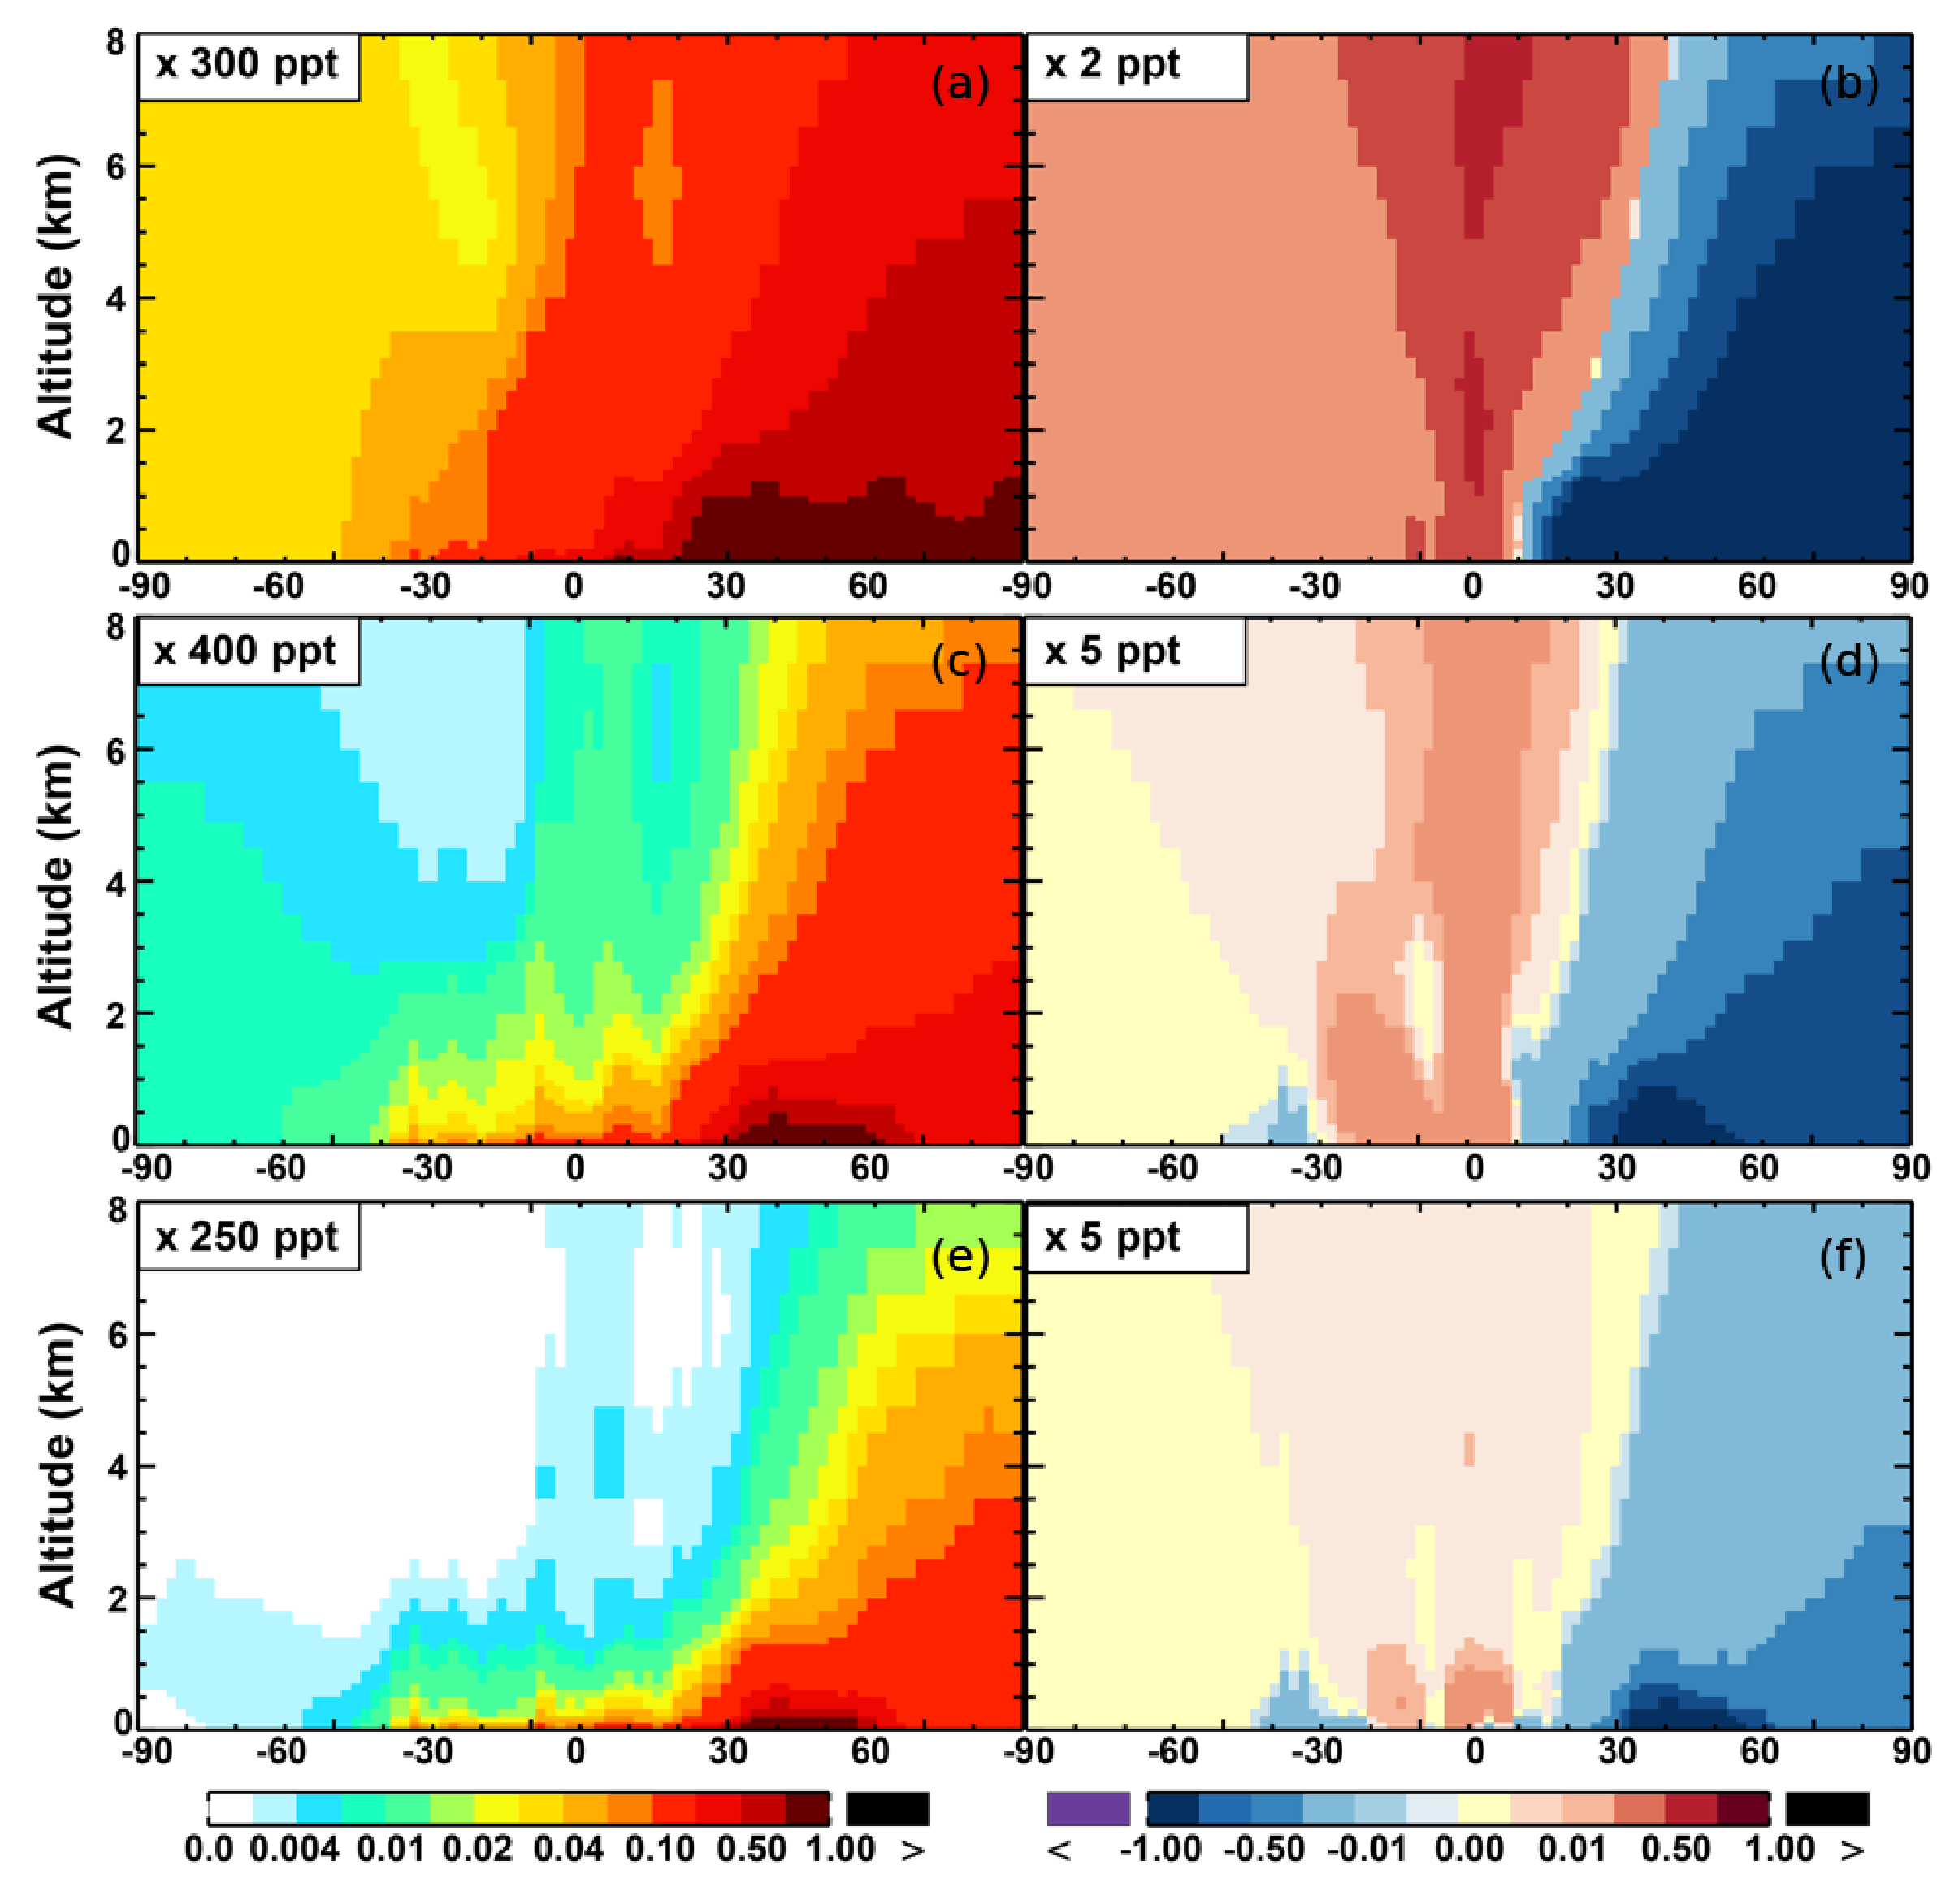
Same as Fig. 7 but for benzene (a, b), toluene (c, d), and xylene (e, f).